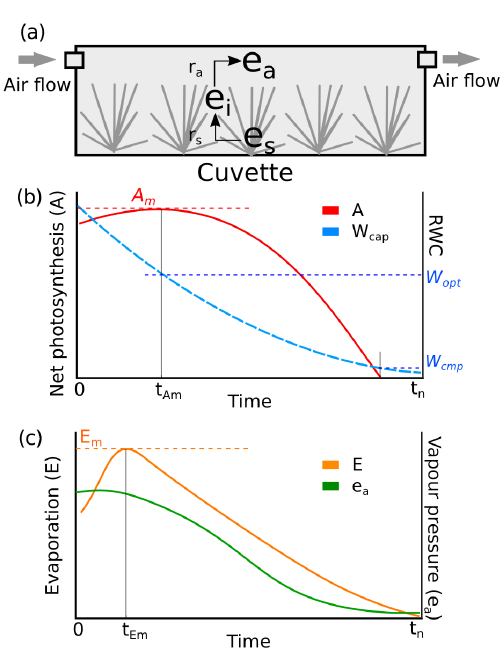
Figure B2. Conceptual schemes of (a) the cuvette setting and re- sistances, (b) the covariations of net photosynthesis and W cap , and (c) the covariations of evaporation and vapour pressure in the headspace during a measurement. The symbols utilized in the figure are as follows: e a is the vapour pressure in the headspace of the cu- vette (kPa); e i is the vapour pressure in the branch-leaf structure of the capitula; e s is the vapour pressure at the surface of wet tissues; r a is the aerodynamic resistance of vapour diffusion from the in- ner capitula to the headspace; r s is the surface resistance of vapour diffusion from the wet tissue surface to the inner capitula space; A is the net photosynthesis rate (µmolm − 2 s − 1 ); A m is the maximal net photosynthesis rate (µmolm − 2 s − 1 ); W cap is the water content of the capitula (gg − 1 ); W opt is W cap at A = A m ; W cmp is W cap at A = 0; E is the evaporation rate (mms − 1